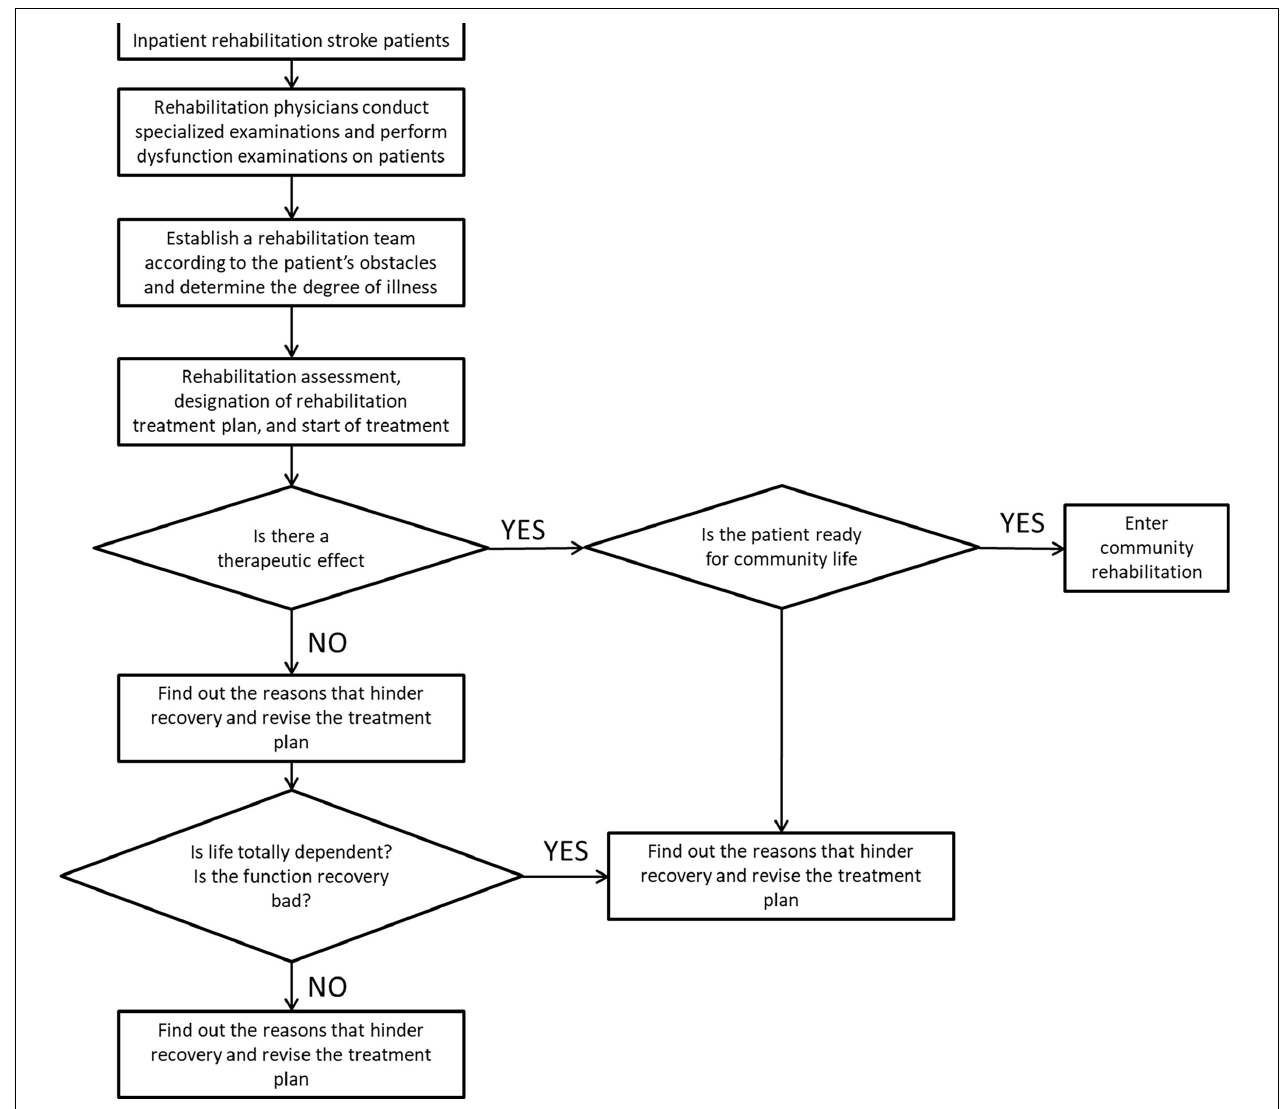
FIGURE 1 | Secondary rehabilitation process for